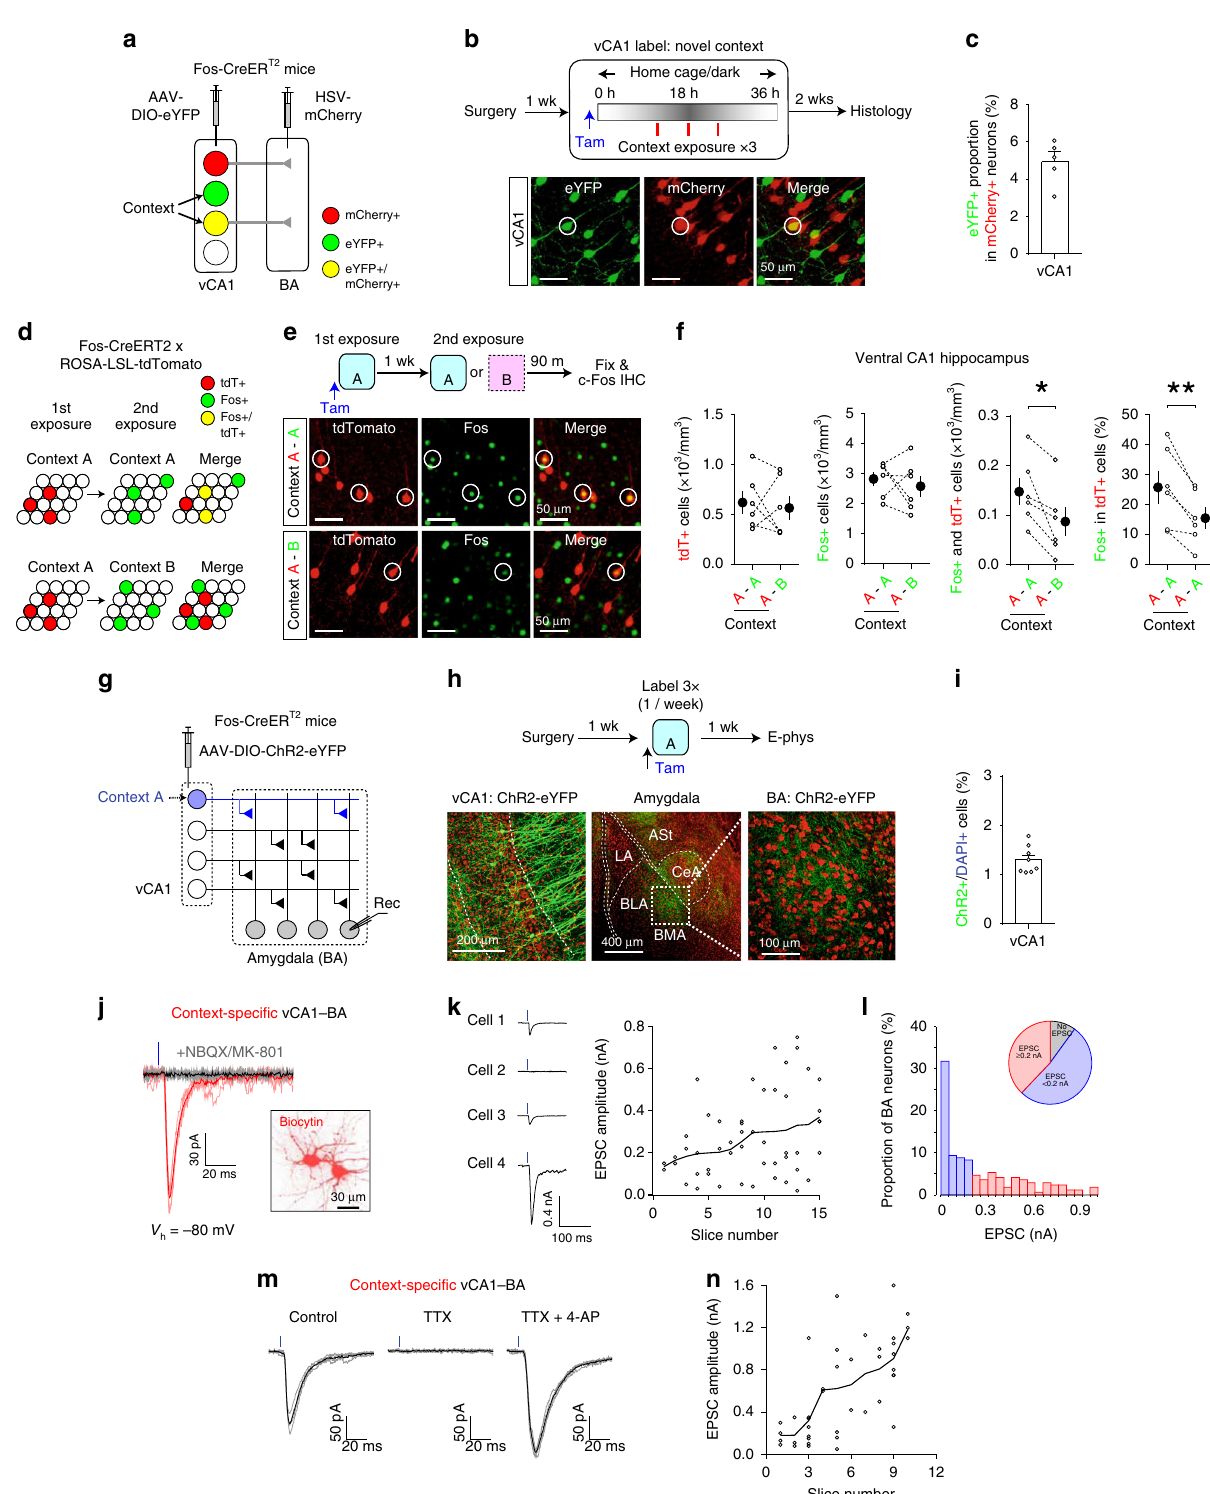
(Fig. 3d). The c-Fos + proportion among all tdTomato-labeled vCA1 neurons as well as c-Fos + and tdTomato + cell density was signi fi cantly higher in mice exposed to the same context (A – A group) than in mice exposed to different contexts (A – B group), whereas there was no signi fi cant difference in tdTomato + or c- Fos + cell density (Fig. 3e, f and Supplementary Fig. 4e – g). In a separate experiment, more vCA1 neurons were labeled with tdTomato in mice exposed to a novel context than in mice that